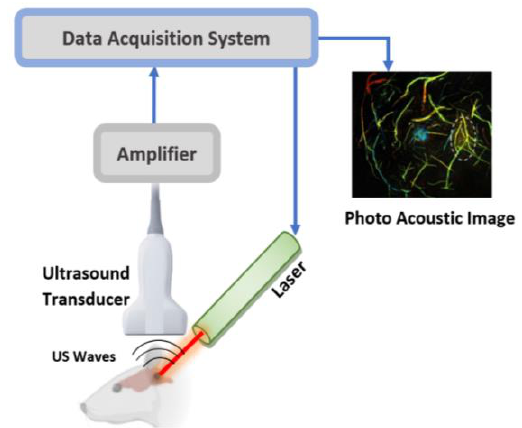
Figure 3. The basic setup of photoacoustic imaging (PAI) includes a pulse laser, ultrasound transducer and data acquisition